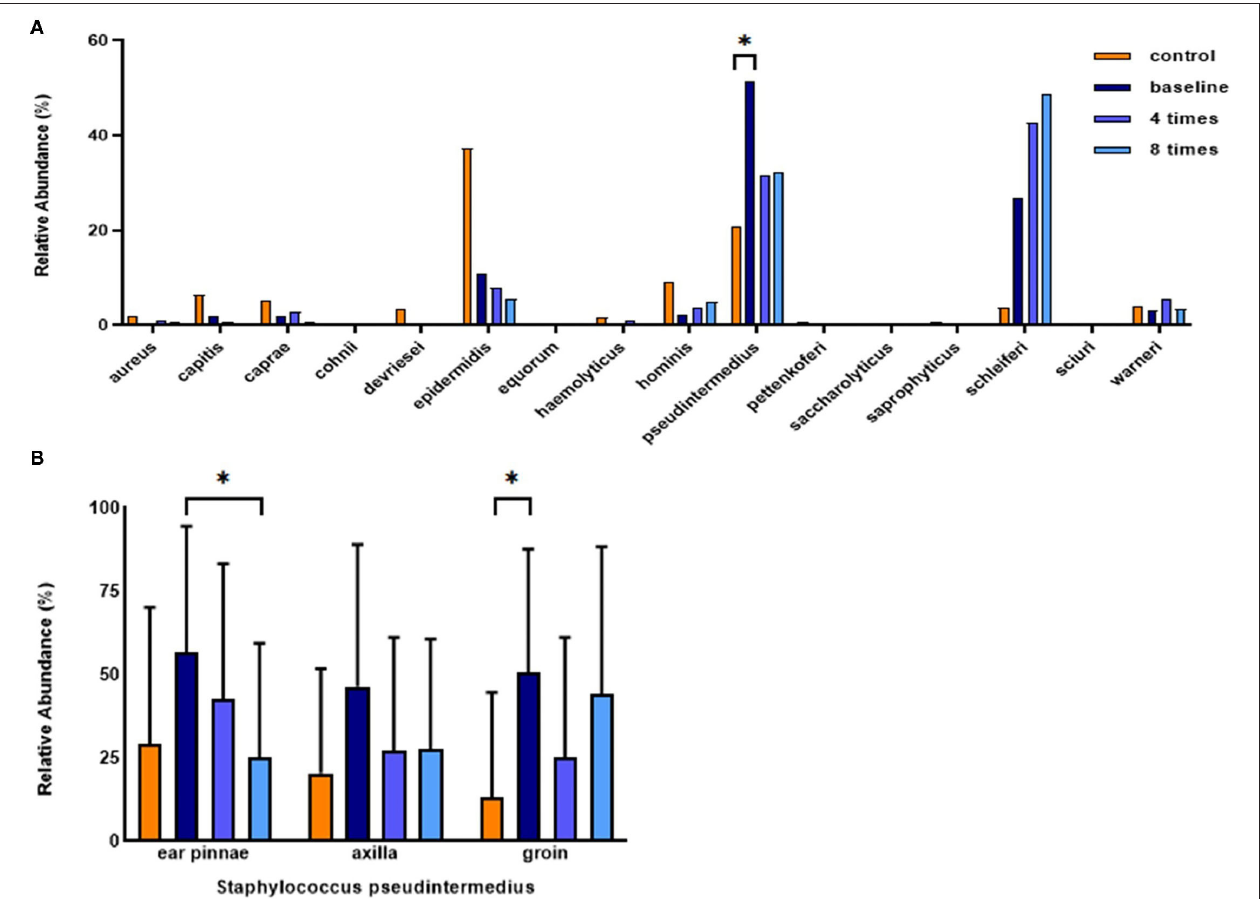
FIGURE 9 | Analysis of Staphylococcus species and change in Staphylococcus pseudintermedius in the course of excimer light therapy. (A) Individual composition of Staphylococcus species in the control and allergic groups. (B) Statistical analysis of the relative abundance of S. pseudintermedius . Four times, fourth session of excimer light therapy in the allergic group; eight times, end of the excimer light therapy in the allergic group; baseline, before the start of excimer light therapy in allergic group. All values are expressed as mean ± standard error. * P <